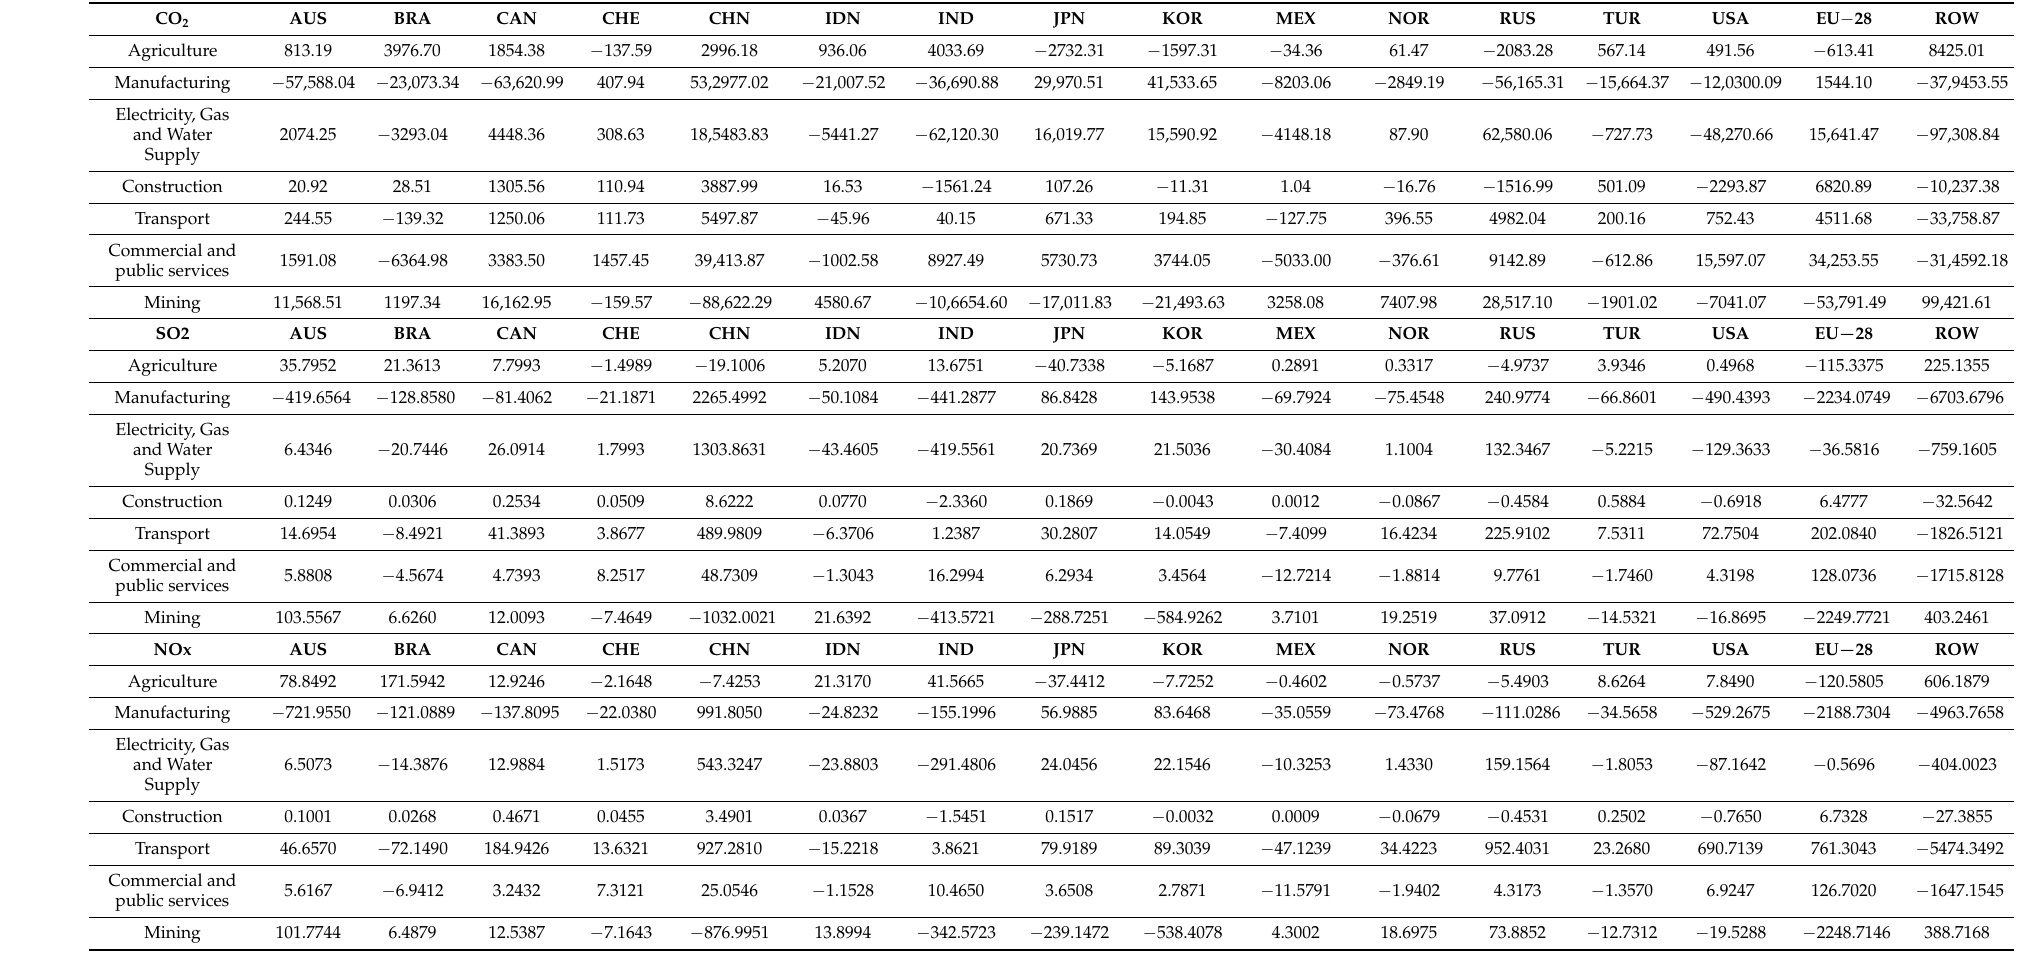
Table A7. Pollution haven phenomena in different